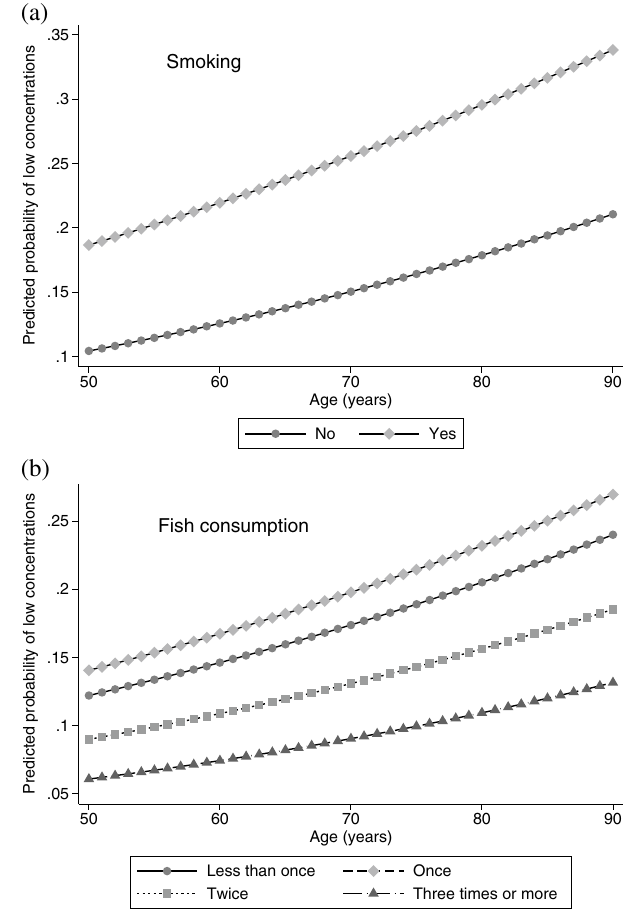
Figure 2. Adjusted predicted probabilities of 25OHD serum concentration below < 50 nmol/L along age continuum, by current smoking ( a ) and frequency of weekly fish consumption ( b ) in participants of the Brazilian Longitudinal Study of Aging (ELSI), 2015–16. The probabilities are adjusted for all variables listed in Table